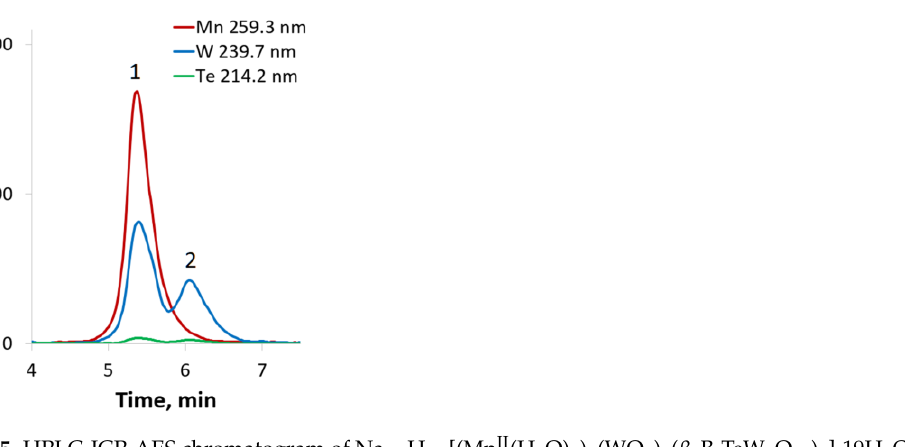
Figure 5. HPLC-ICP-AES chromatogram of Na 4.6 H 3.4 [(Mn II (H 2 O) 3 ) 2 (WO 2 ) 2 ( β -B-TeW 9 O 33 ) 2 ] · 19H 2 O in water at natural pH.